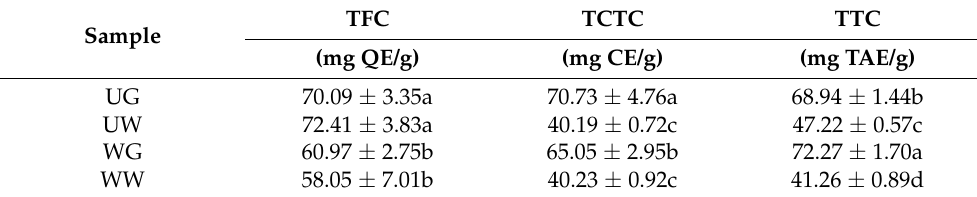
Table 4. Extraction yields of TFC, TCTC, and TTC with four different